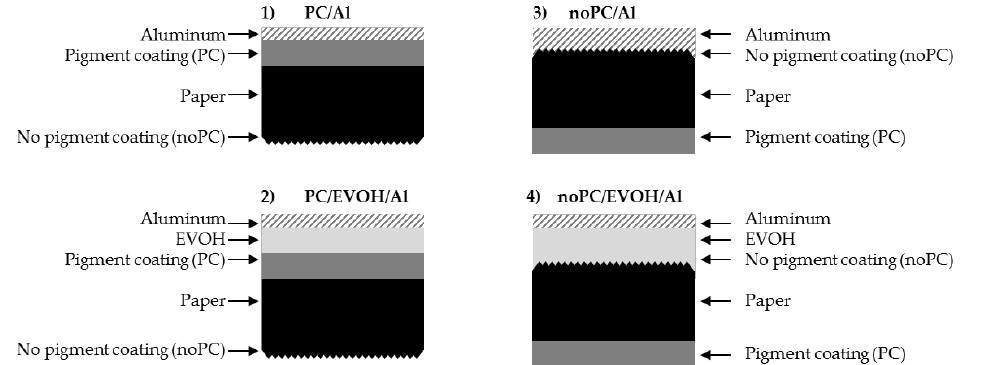
Figure 1. A schematic description of the samples that were produced, as described in the previous